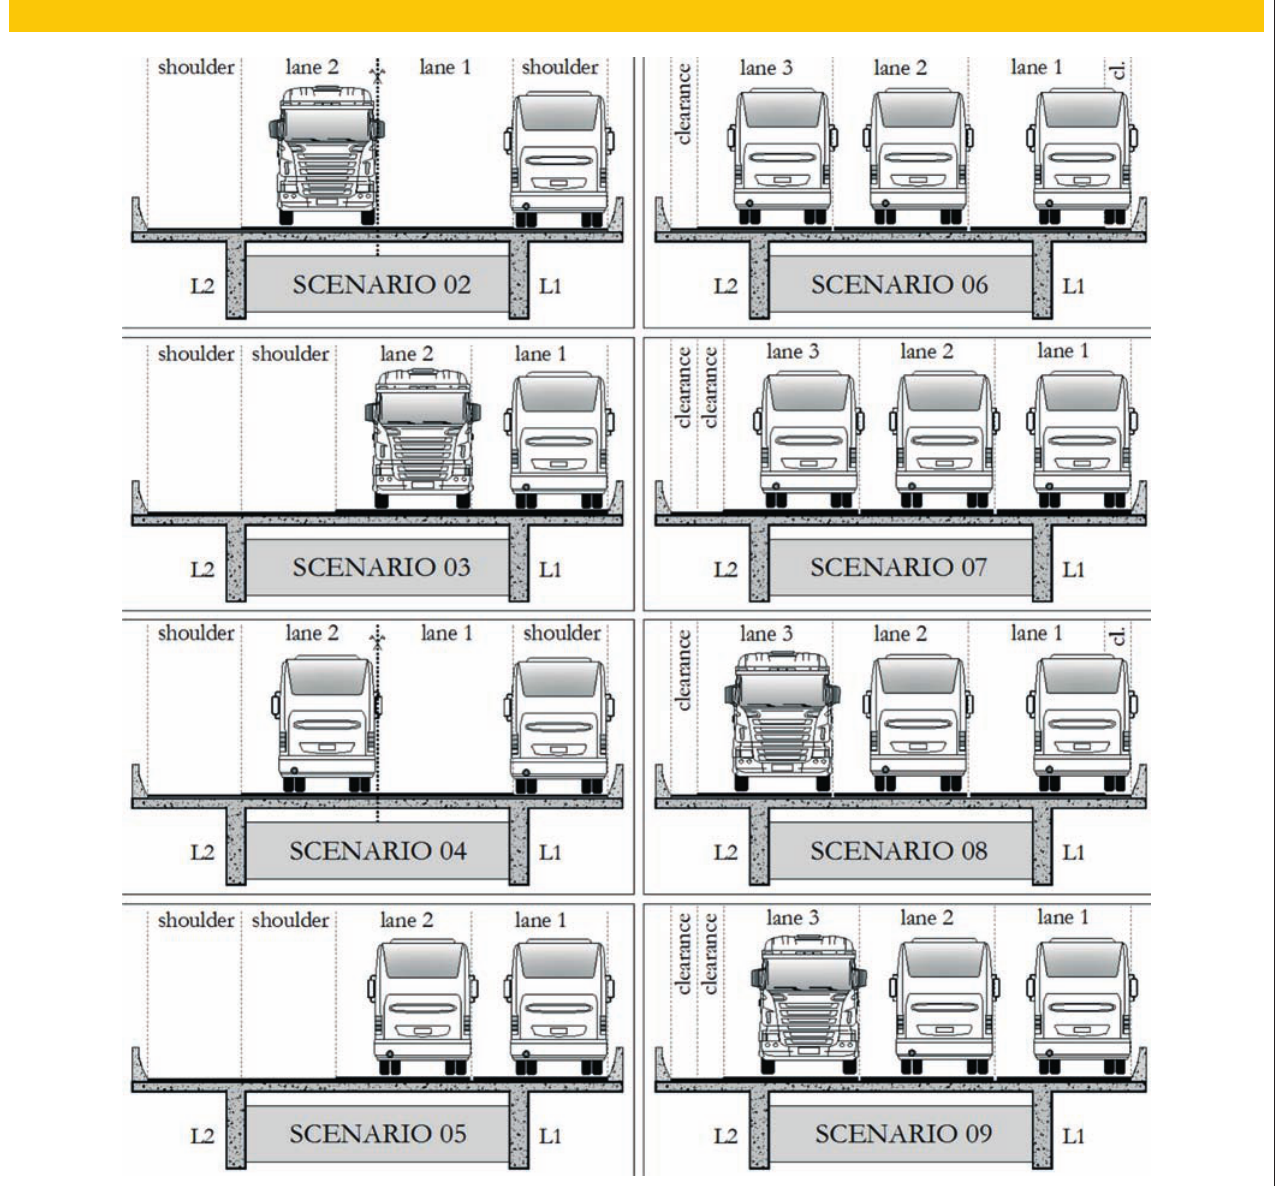
Figure 8 – Free flowing scenarios considered to design (ultimate limit